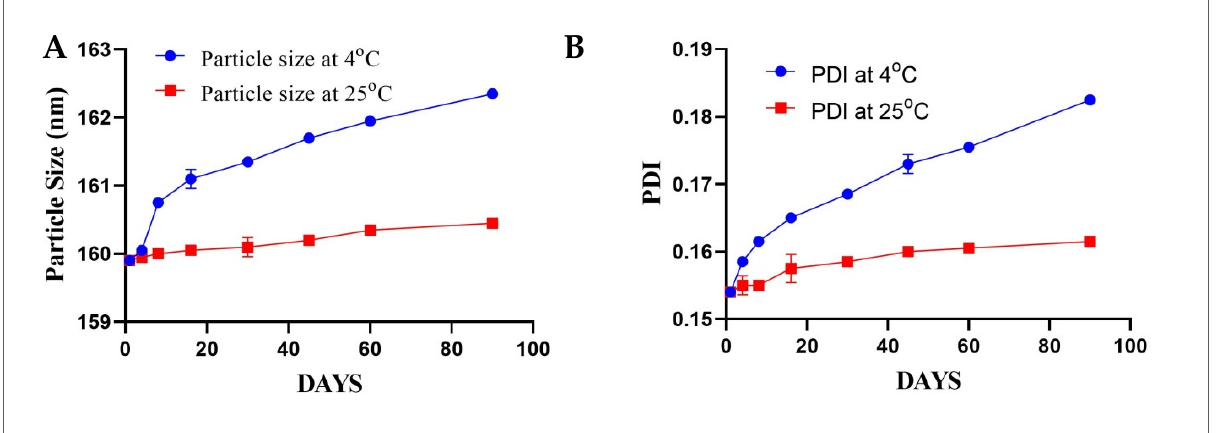
Figure 9. Effect of storage condition on particle size and PDI of M + T SLNs ( A ) Particle Size ( B ) PDI. The data is presented in mean ± SD ( n = 3).